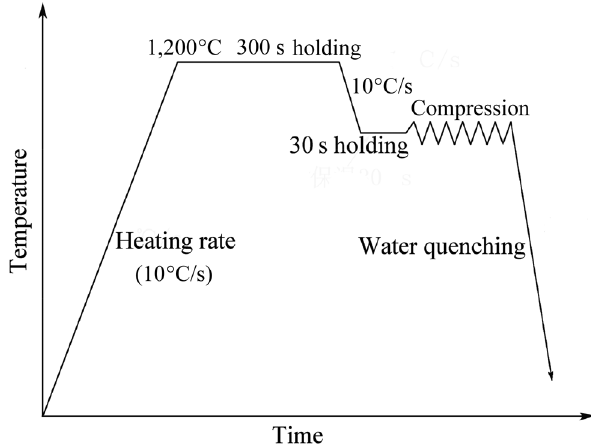
Figure 1: Schematic diagram of compression